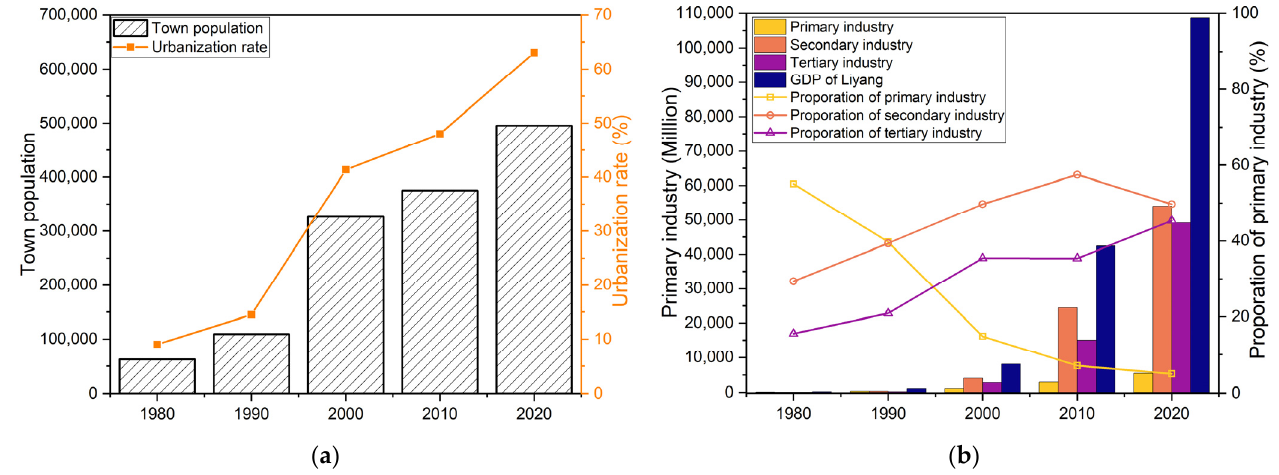
Figure 2. Development of Liyang from 1980 to 2020. ( a ) Urbanization process; ( b ) Industry develop- ment process. Table 1. Data sources and